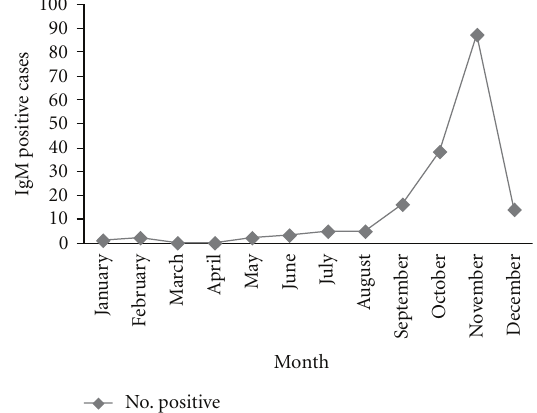
Figure 2: Monthly distributions of IgM-positive dengue cases in 2010.